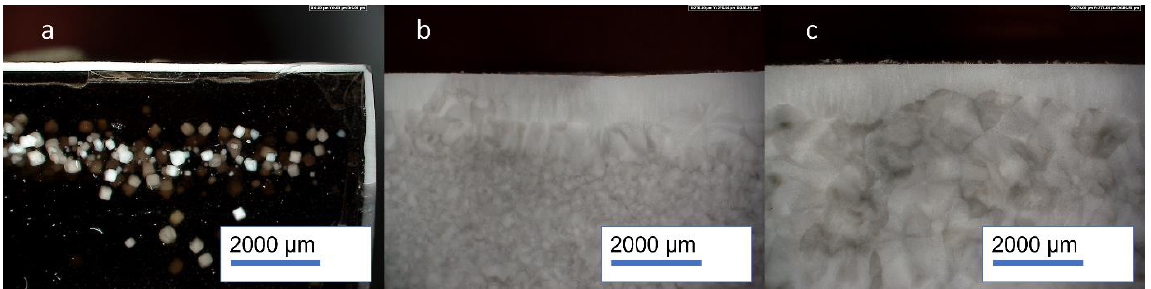
Figure 10. Optical microscope images of samples of parent glass C2 heat treated at 850 °C for 1 h ( a )